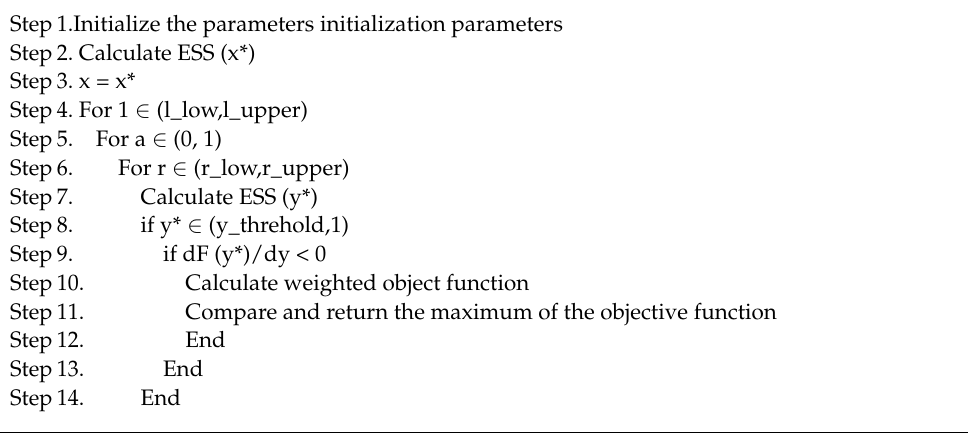
Algorithm 1 Optimization algorithm pseudo